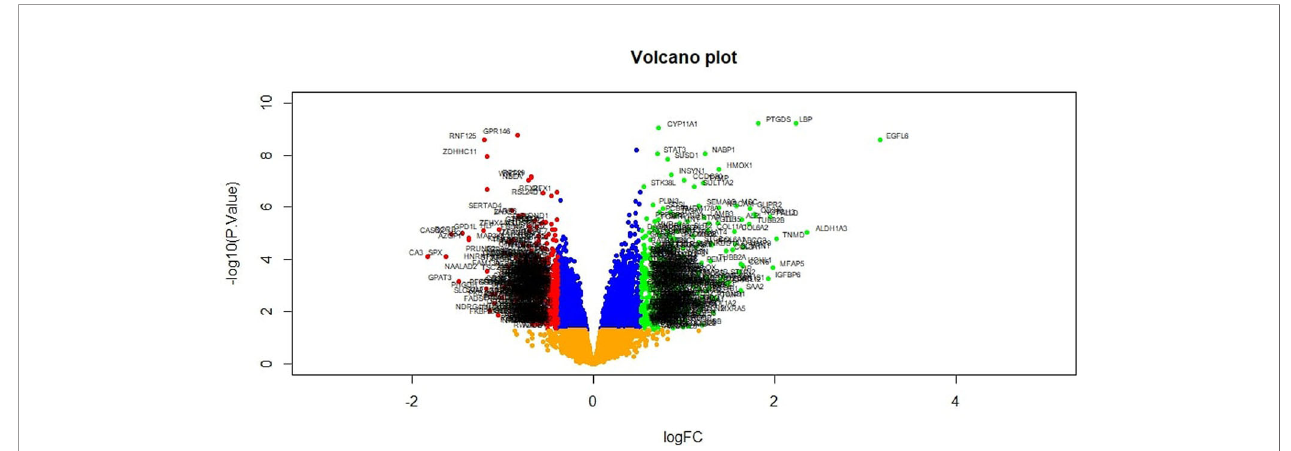
FIGURE 3 | Volcano plot of differentially expressed genes. Genes with a signi fi cant change of more than two-fold were